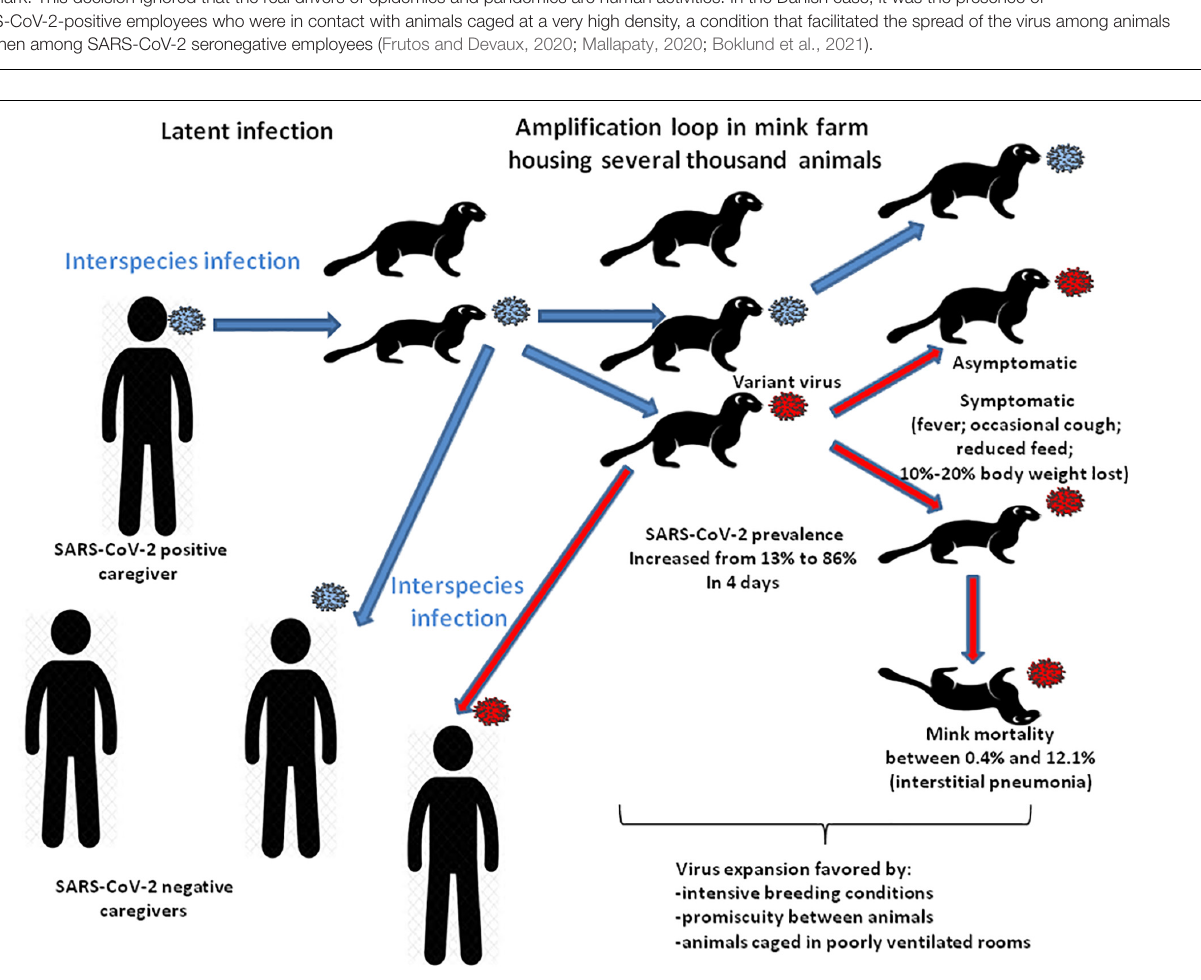
FIGURE 3 | Schematic representation of the SARS-CoV-2 spread in mink farms. Infected animals reduced feed intake and lost body weight. The virus expansion in mink farms was favored by intensive breeding conditions with significant overcrowding in poorly ventilated rooms. Minks ( M. lutreola in Netherlands and N. vison in Denmark) infected with SARS-CoV-2 were found to be either asymptomatic or to display signs of respiratory diseases (several animals died from interstitial pneumonia or sepsis). For fear of seeing minks-selected SARS-CoV-2 variants spreading more easily among people, of being more deadly, or having a negative impact on the deployment of anti-COVID-19 vaccines (interfering with vaccine effectiveness in humans), the Danish government decided to cull 17 million minks in more than 1,000 farms (Koopman, 2020; Larsen and Paludan, 2020; Oude Munnink et al., 2021). Countries who reported SARS-CoV-2 infected minks in farms, i.e., Netherlands, Ireland, Greece, Spain, Italy, France, United States, also started a mass